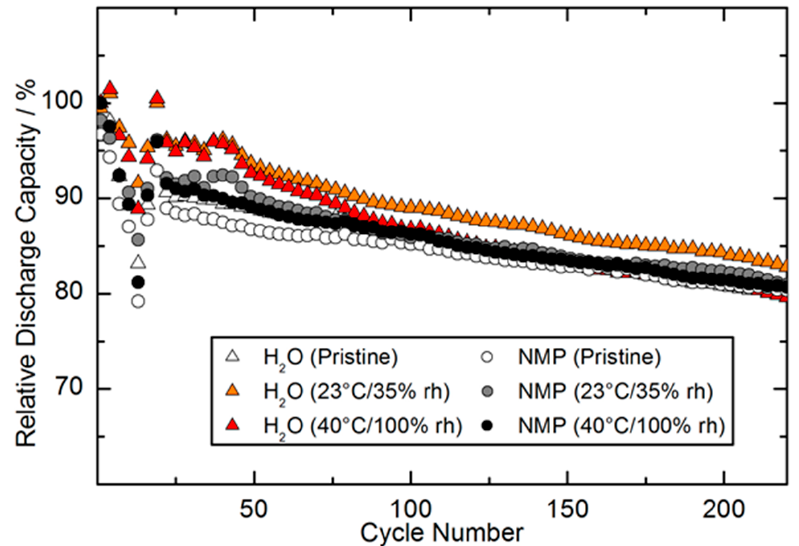
Figure 5. Relative discharge capacities at a 1 C-rate of full-cells assembled with cathodes representing all combinations of ageing conditions and solvents used for slurry preparation. The highest specific discharge capacity (120.6 mAh·g − 1 , observed for full-cells assembled with water-based cathodes produced with LFMP aged at 40 ◦ C and 100% rh) was set to 100% and all other discharge capacity into relative relation to this value. Legend indicates the solvent used for slurry preparation and the initial powder sample storage conditions are in brackets.